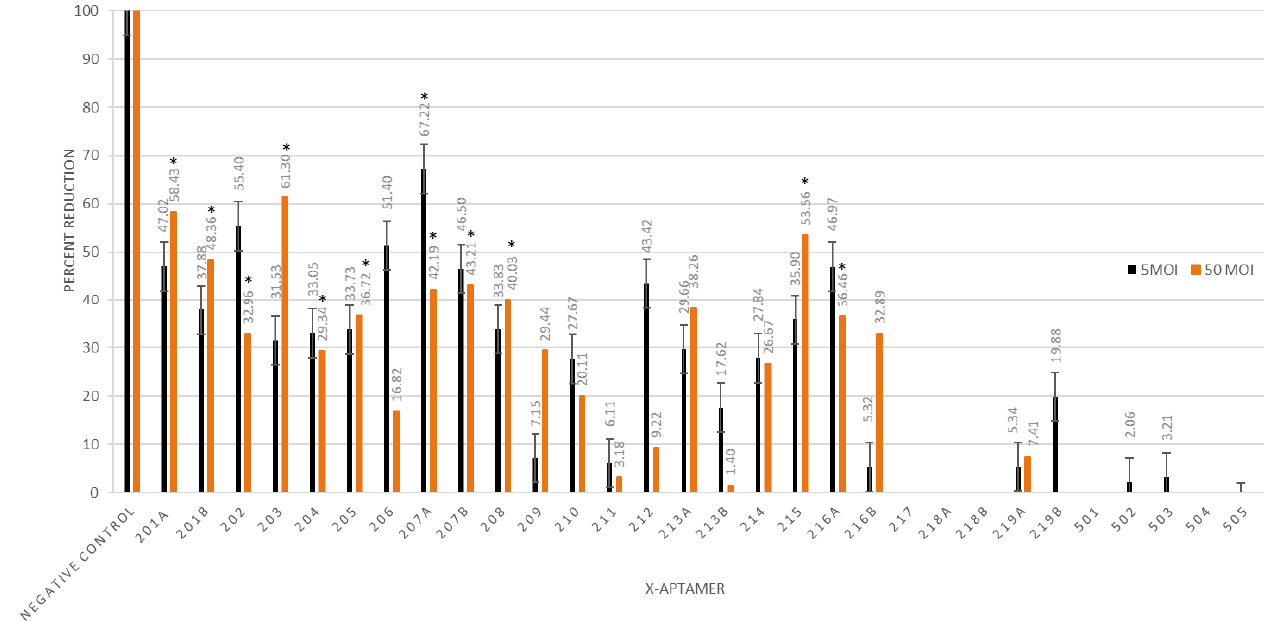
Figure 2. Mean percent reduction ( Y -axis) of X-aptamers (30 nM) targeting RABV CVS-11-infected cells (5 and 50 MOI) with treatment occurring 2 h post infection. All of the experiments were undertaken in sextuplicate. * indicates significant reduction ( p < 0.05) compared to the mean of the positive control. For display purposes, the negative control has been set in relation to the positive control, but no reduction was observed for the negative control. Chimera challenge trials.